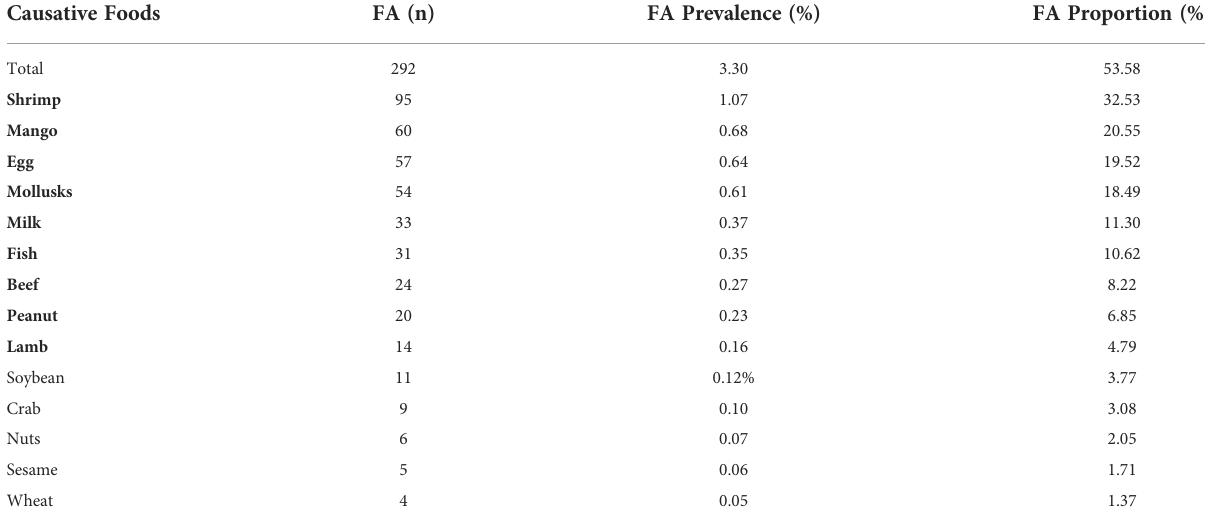
TABLE 3 Causative foods of the parent-reported doctor-diagnosed food allergy. Causative